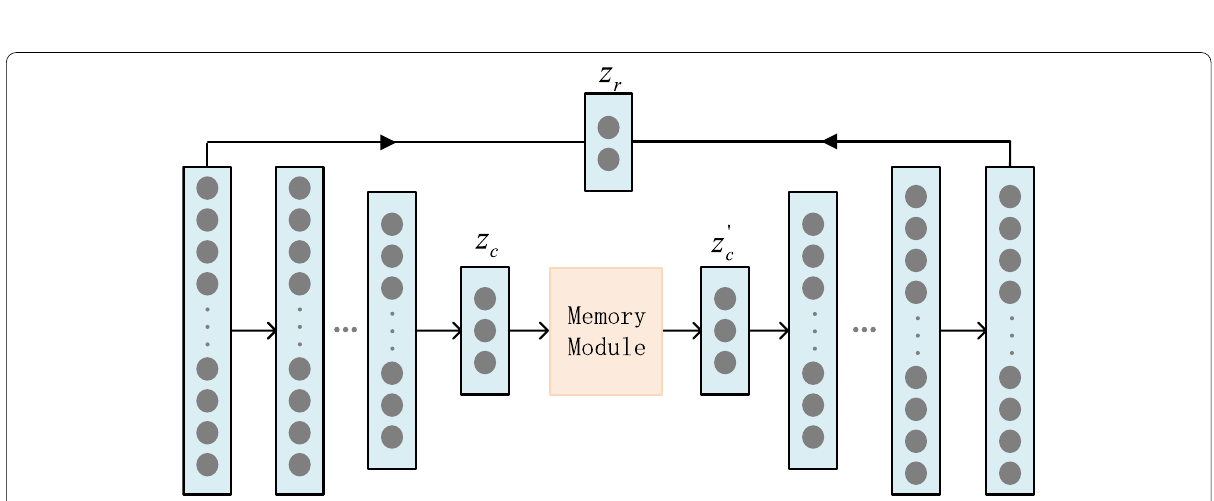
Fig. 4 Low-dimensional information network structure